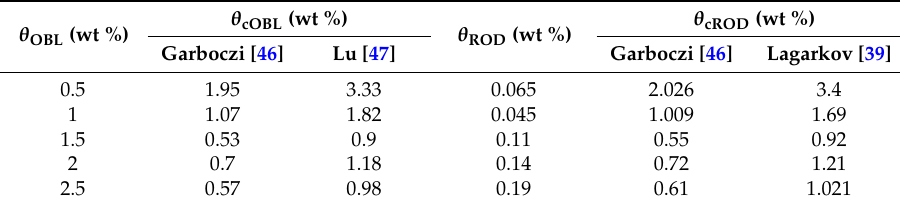
Table 4. Percolation thresholds of composites filled either with oblate ellipsoids at different concentrations in wt % ( θ OBL ) or with cylindrical rods at different concentrations in wt % ( θ ROD ), having the geometrical dimensions reported in Table